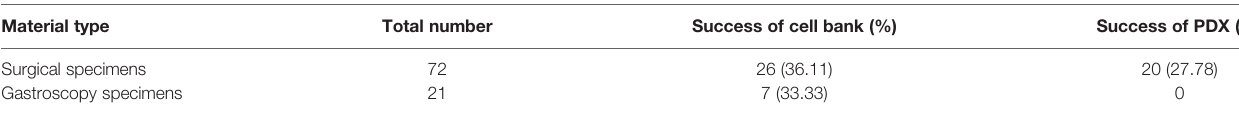
TABLE 1 | Cultivation of GC cells with the i-CR system and PDX